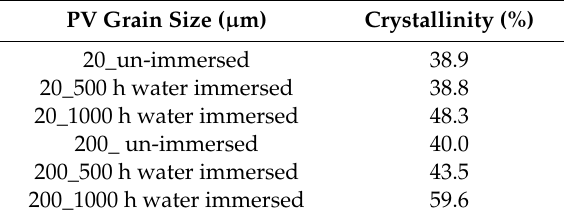
Table 5. The crystallinity of the 20 and 200 microns Si-PV composites.